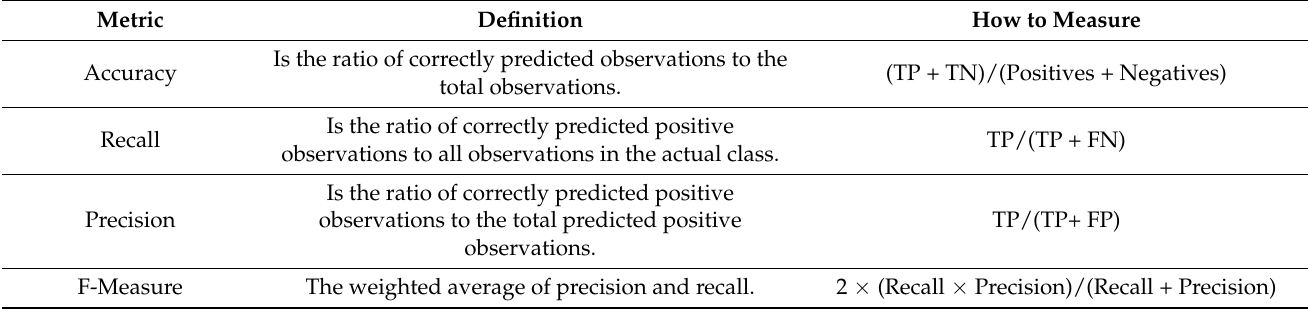
Table 5. Performance metrics.